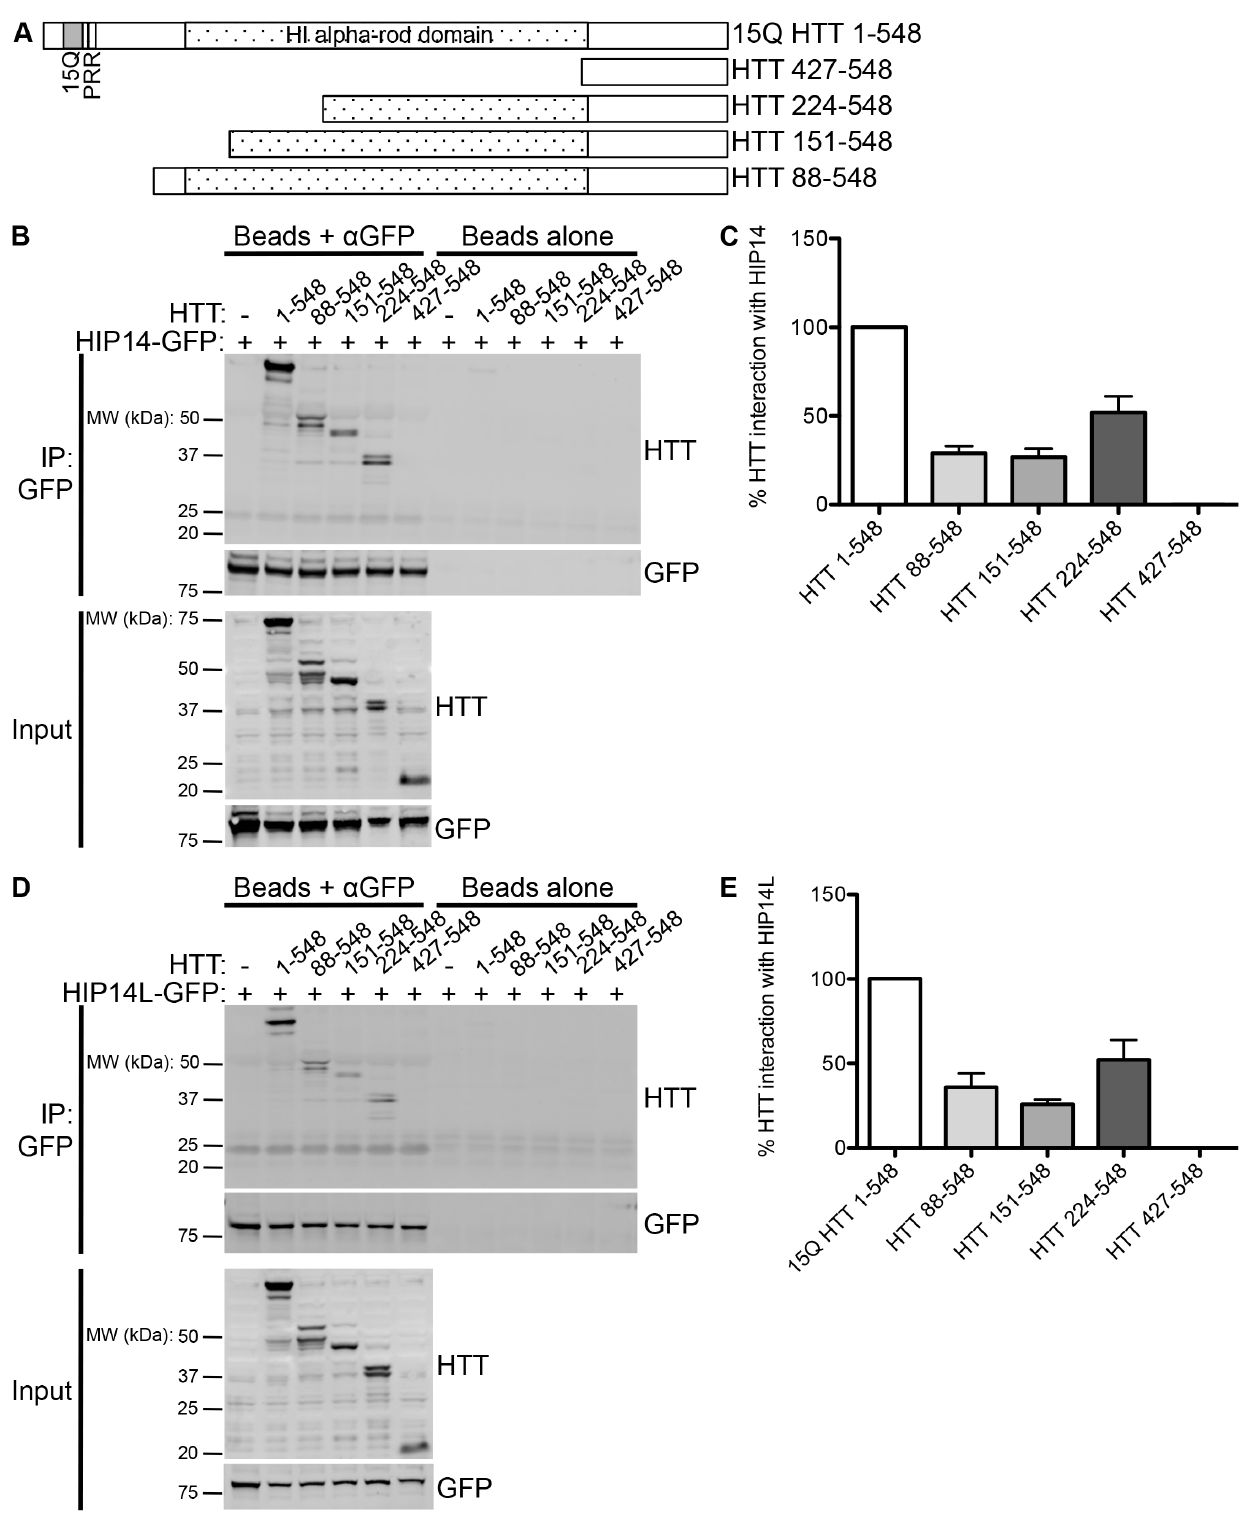
Figure 3. HIP14 and HIP14L interaction with N-terminal deletion mutants of HTT 1–548. ( A ) A diagram of the HTT 1–548 N-terminal deletion mutants used in co-immunoprecipitation experiments with HIP14-GFP and HIP14L-GFP showing the 15Q poly-Q domains, the proline rich region (PRR), and the H1 alpha-rod domain. ( B ) A representative image (top two panels) of the co-immunoprecipitation between these N-terminal deletion mutants and HIP14-GFP where GFP was immunoprecipitated and the resulting blots were probed for HTT (top panel) and GFP (bottom